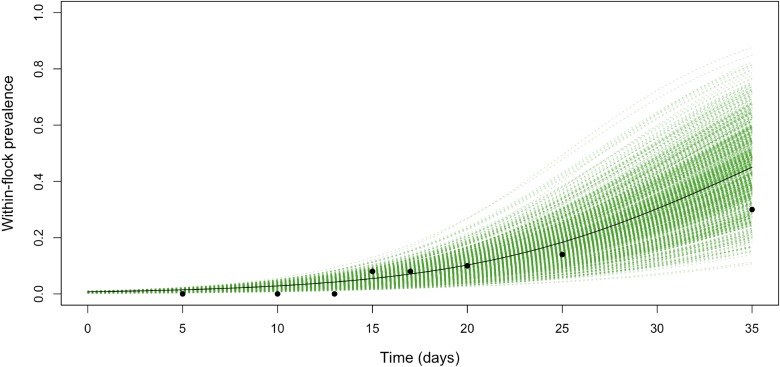
The within-flock prevalence dynamics for a 5000-bird flock in Jordan with a density of birds of around 10 birds/m2, obtained by fitting the model (including 95% credible intervals) to the longitudinal data points.